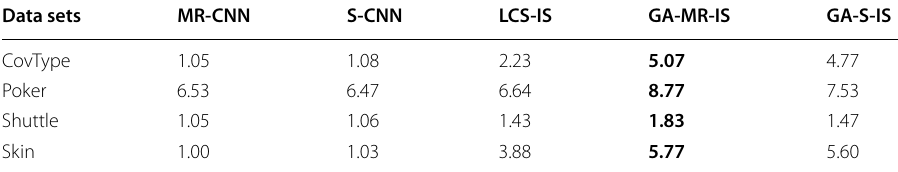
Table 8 The experimental results compared with three related methods on compression ratio Data sets MR-CNN S-CNN LCS-IS